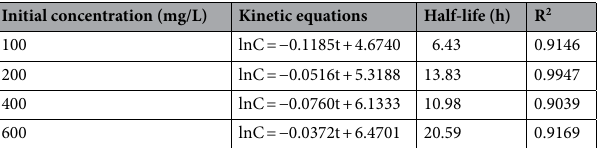
Table 1. Kinetics of DEHP degradation by Nocardia asteroides LMB-7 at different initial concentrations.